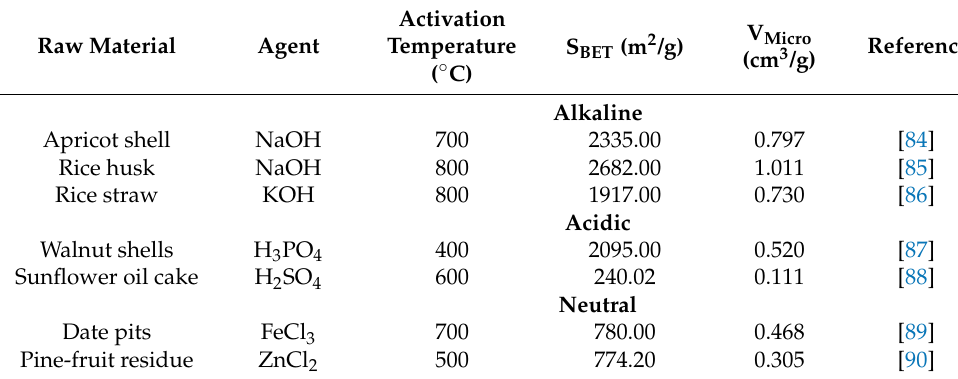
Table 4. Chemical activation of various biowaste.